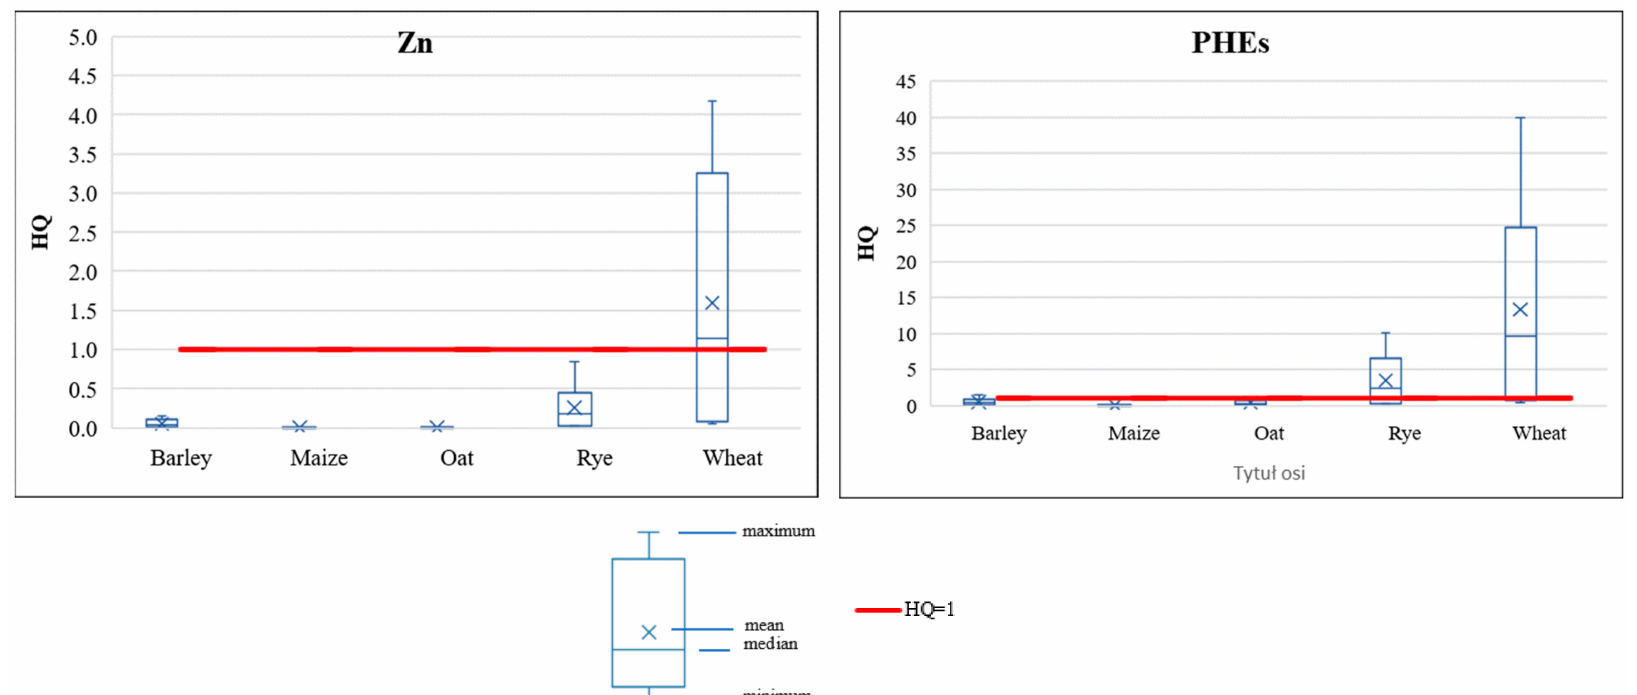
Figure 4. The non-carcinogenic risk values (HQ) of PHEs caused by cereal ingestion under the analyzed intake